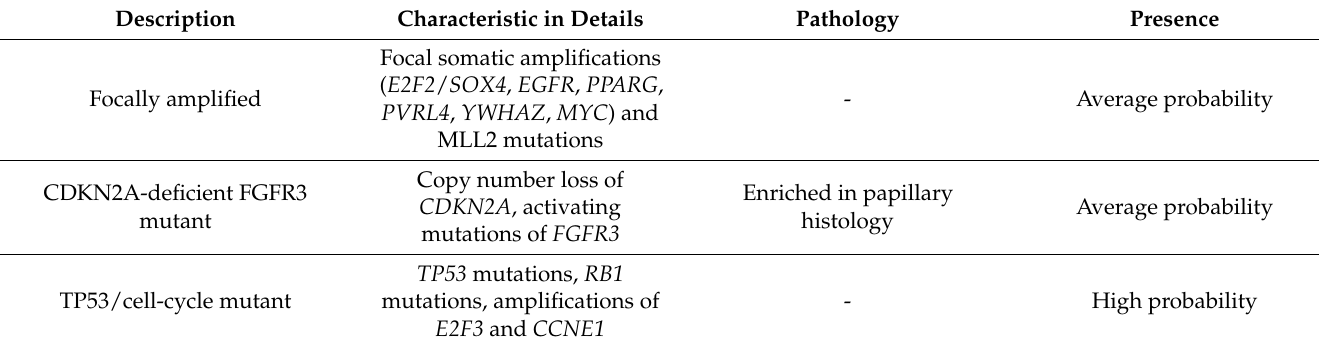
Table A3. Molecular classification of bladder cancer (adaptation from Young Seok Ju